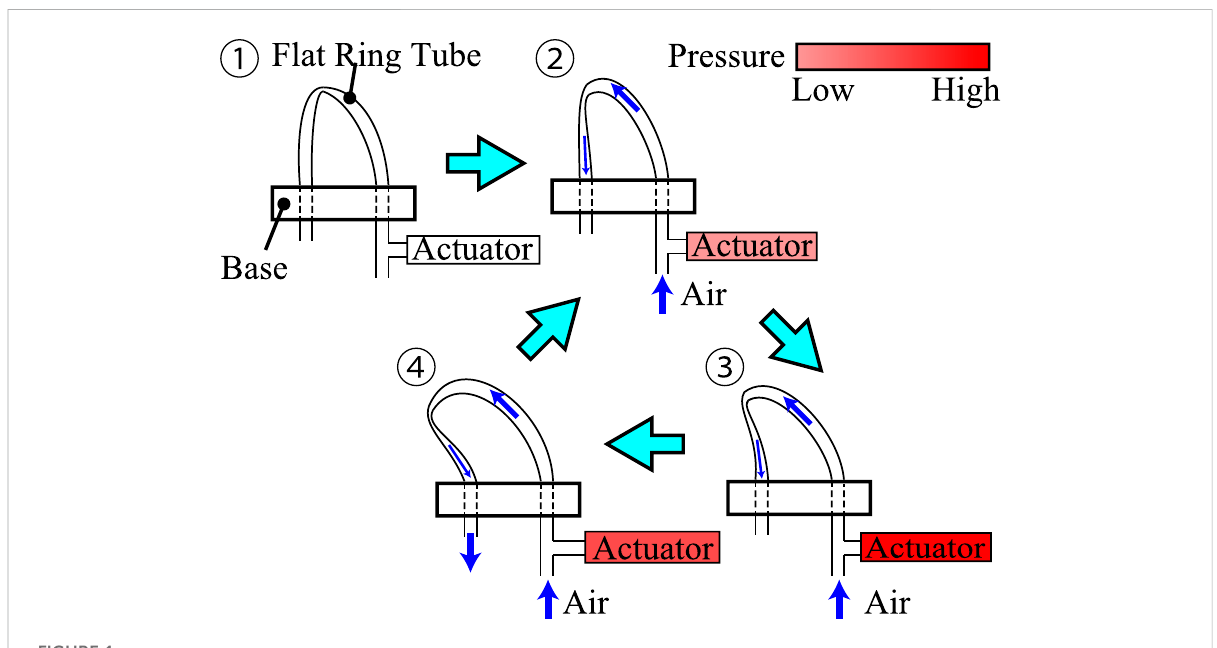
FIGURE 1 Self-excited oscillation of a fl at ring tube produces cyclic pressure changes in an actuator.